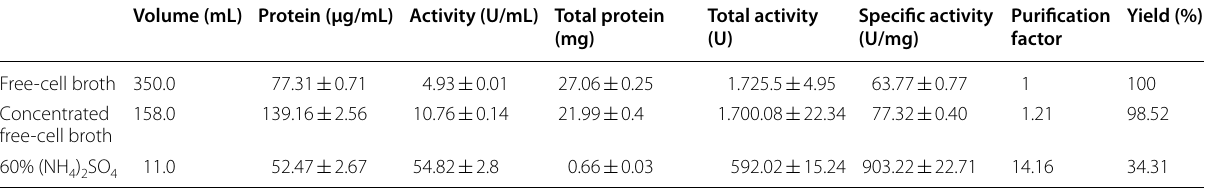
file 1: Fig. S3 shows the peptide fingerprint result of par-